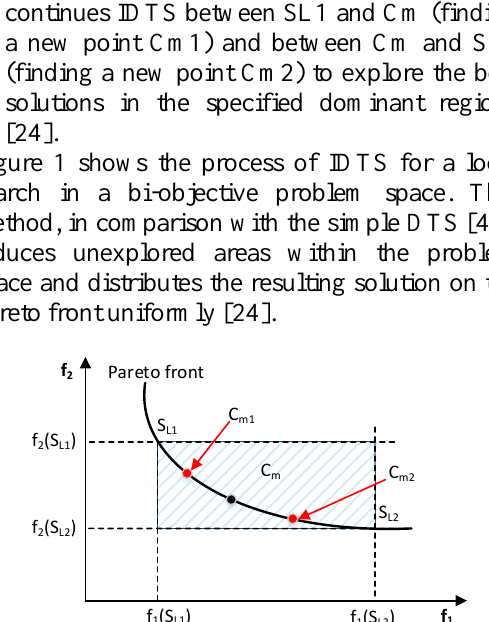
Algorithm 2. TS general framework